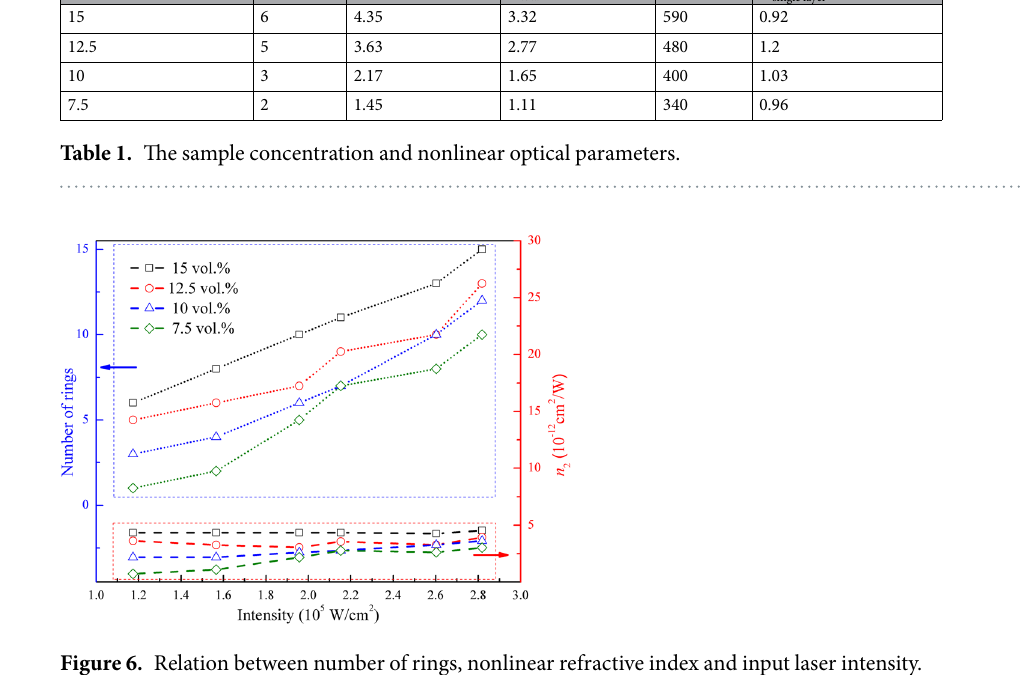
Figure 6. Relation between number of rings, nonlinear refractive index and input laser